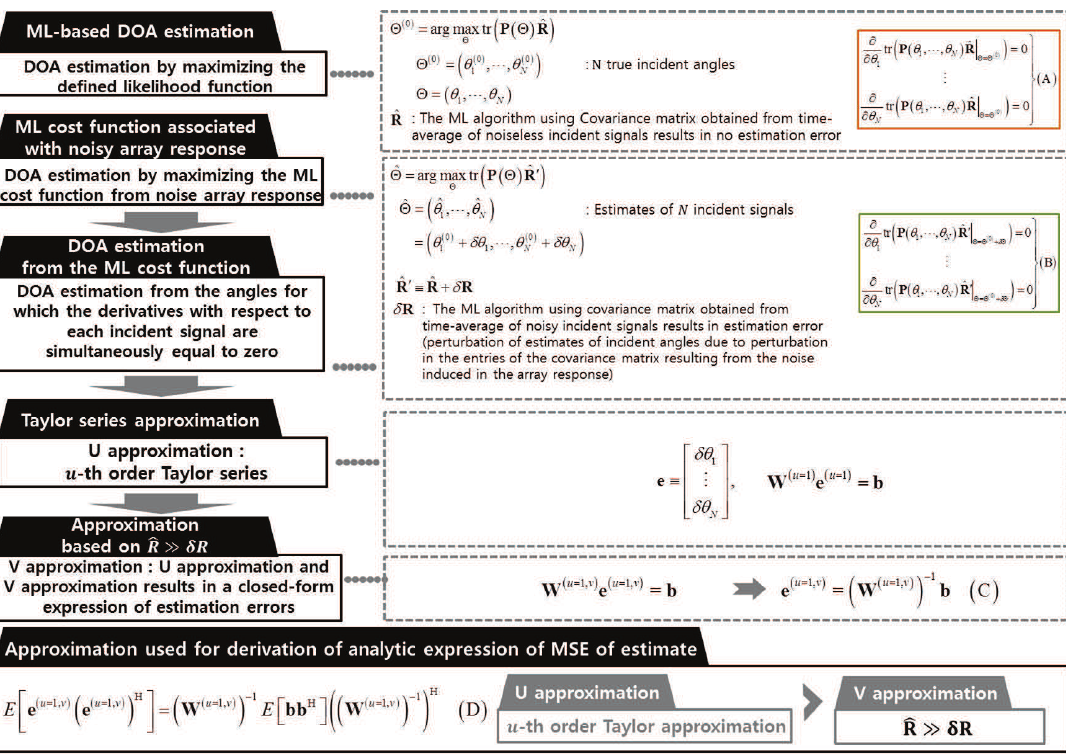
Figure 6. Outline of the proposed performance analysis